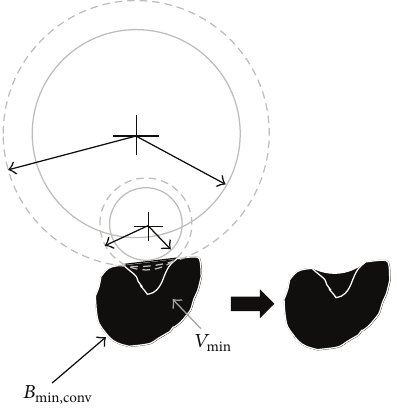
Figure 8: Successive application of the diffraction-based estimation of the critical sphere of radius 𝑅 int min , based on field information avail- able from previous iterations. This method allows the estimation of concave boundaries of the minimum source region. Thus it allows, in theory, the estimation of the minimum source region 𝑉 min which can be nonconvex.